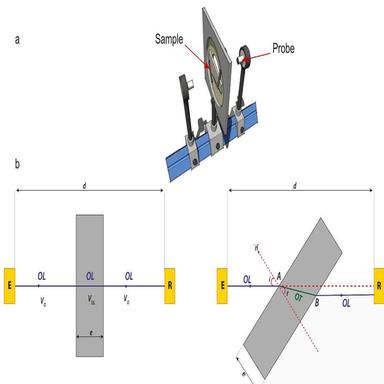
A schematic of the ultrasonic method; (a) configuration of sample and probes, and (b) sample rotation for removing OL wave and appearing OT wave.